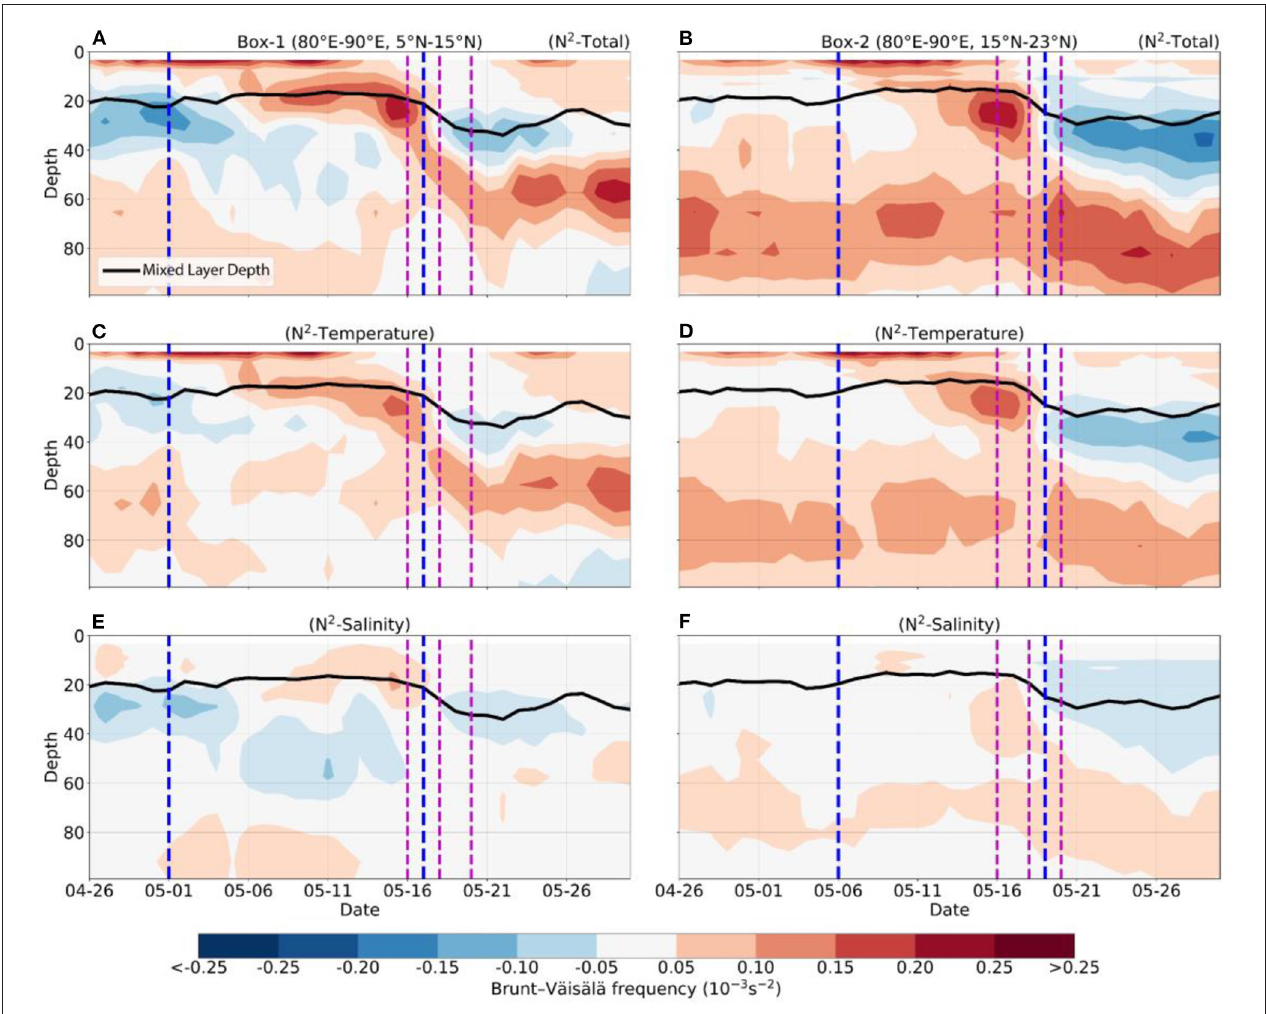
FIGURE 6 | Brunt–Väisälä frequency anomaly ( N 2 , s − 2 ) for the upper 100m of the ocean for (A) box 1, (B) box 2, N 2 contributed from the temperature ( N 2 -Temperature) for (C) box 1 and (D) box 2, N 2 contributed from the salinity ( N 2 -Salinity) for (E) box 1 and (F) box 2 for the duration of 26-April-2020 to 30-May-2020 with mixed layer depth (black), vertical blue lines represent marine heatwave duration and vertical magenta lines representing cyclogenesis (left, 16-May-2020), cyclone intensification (middle, 18-May-2020) and landfall (right, 20-May-2020) for the tropical cyclone